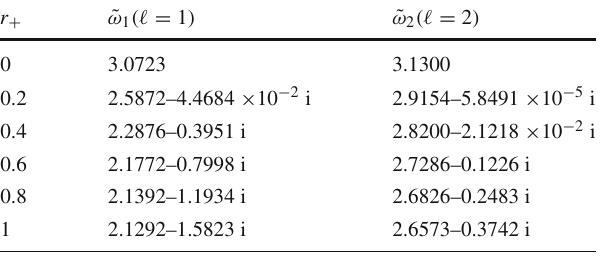
Table 1 Quasinormal frequencies of the Maxwell fields on global monopole-Schwarzchild-AdS black holes with 8 πη 2 = 0 . 1, N = 0, and for different black hole sizes r + with two different boundary con- ditions r +